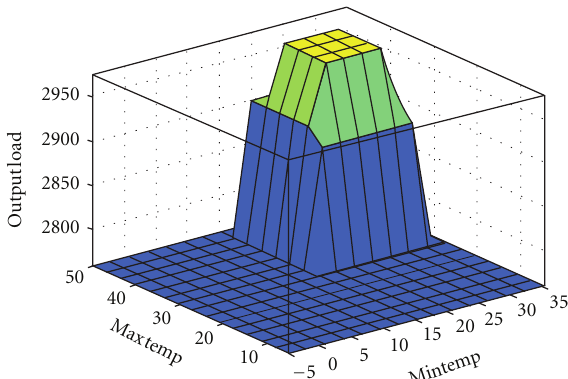
Figure 5: Surface viewer of fuzzy system.